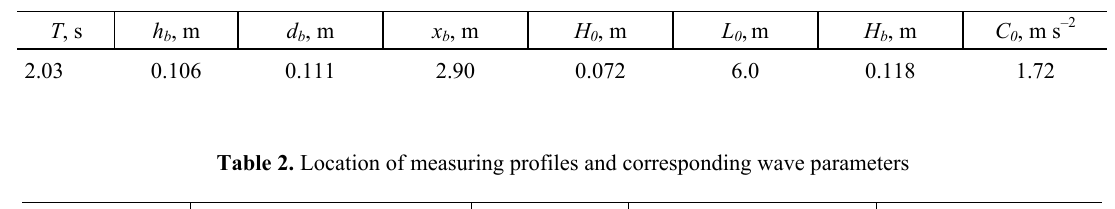
Table 1. Regular wave characteristics